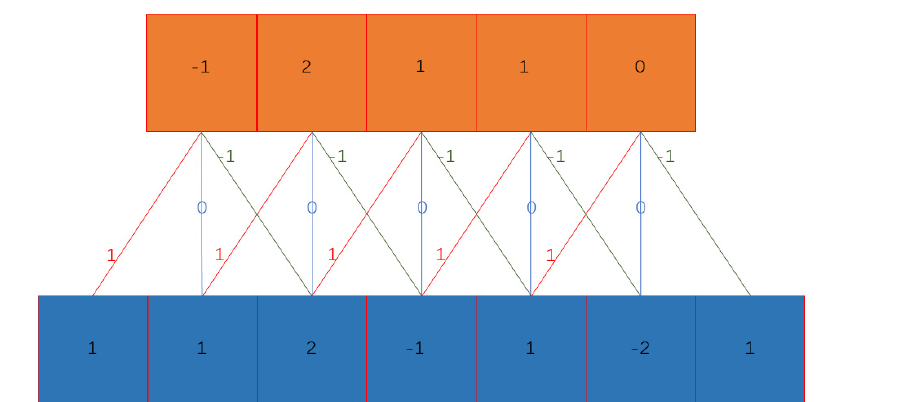
Figure 1. Structure of 1DAAE model.